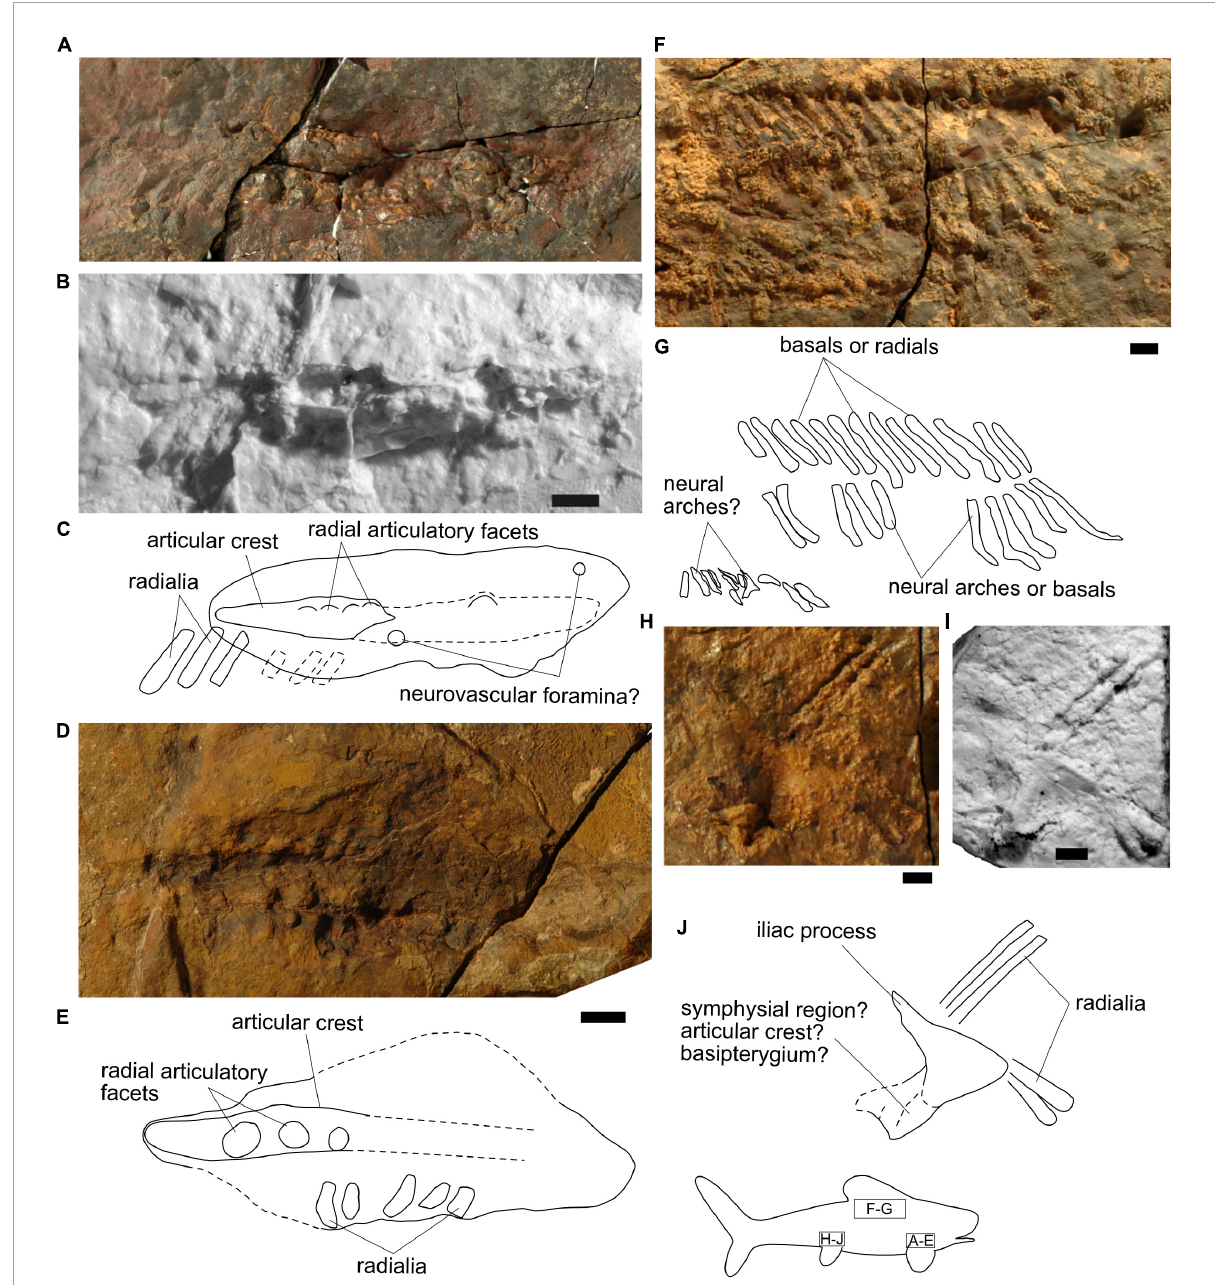
FIGURE6 Post-thoracic structures of Amazichthys trinajsticae gen. et sp. nov. Scapulocoracoid of PIMUZ A/I 4773 (A–C) and PIMUZ A/I 5140 (D,E) , basals of the dorsal fin in PIMUZ A/I 4773 (F,G) and pelvic girdle of AA.MEM.DS.8 (H–J) . Scale bars correspond to 10 mm.